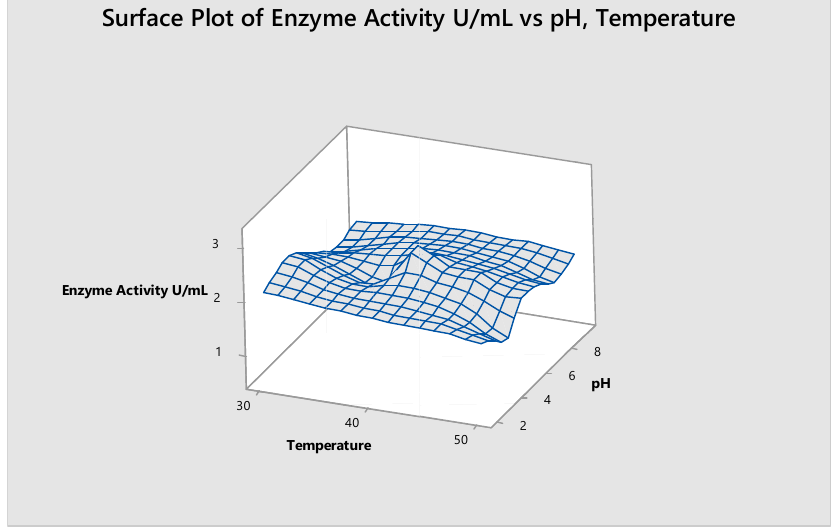
Figure 8. Surface plot of Enzyme Activity (U/mL) vs. pH and Temperature.